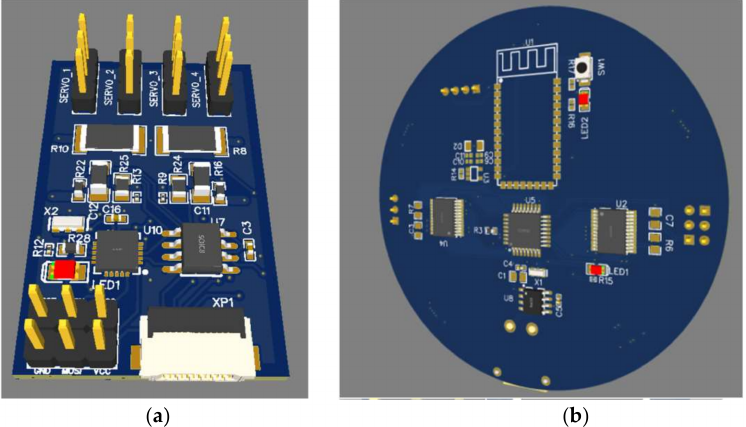
Figure 7. Appearance of the designed board: ( a ) current measurements via servos; ( b ) control